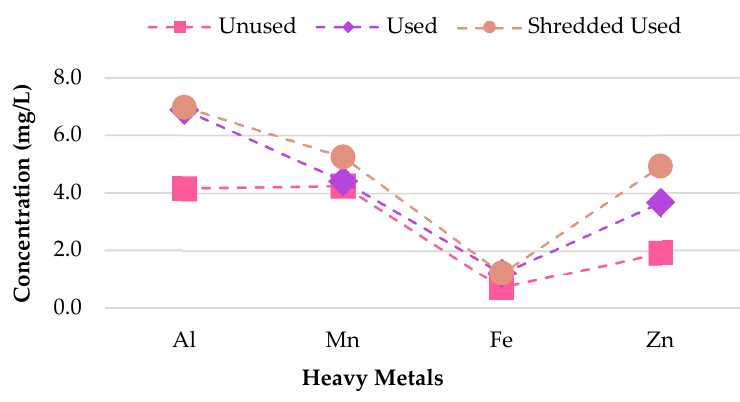
Figure 10. Al, Mn, Fe, and Zn leachate concentrations for pH 5.0.